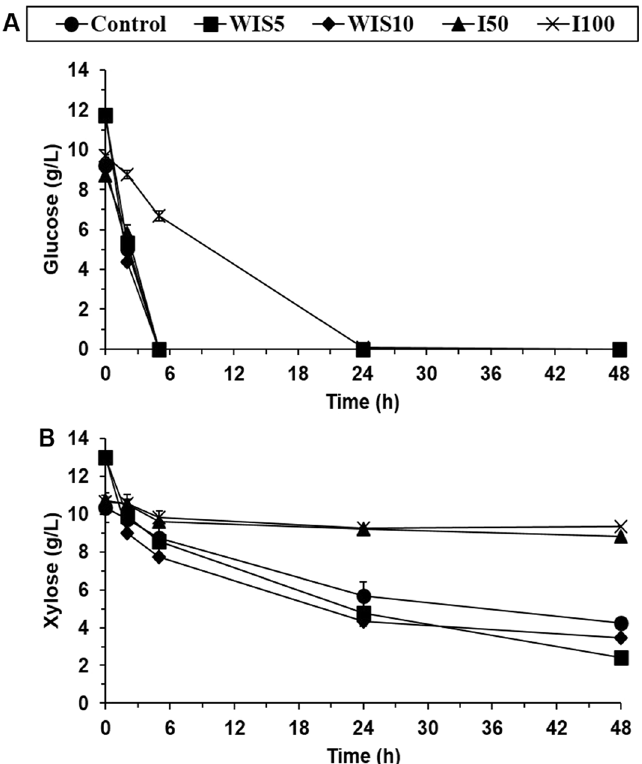
Figure 1. Time-course for ( A ) glucose and ( B ) xylose consumption during fermentation assays in presence of different concentrations of WIS and lignocellulose-derived inhibitors.